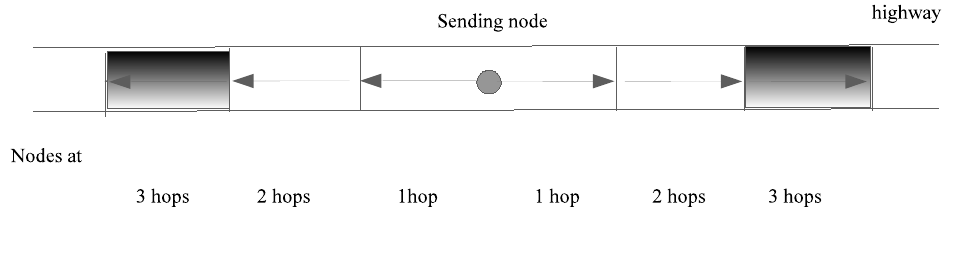
Figure 4. Node locations in 1D highway